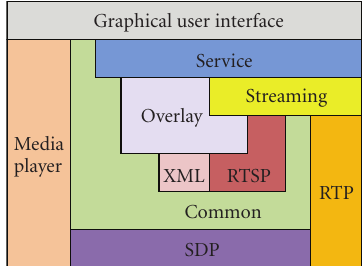
Figure 10: Architecture of the RTP2P streaming application